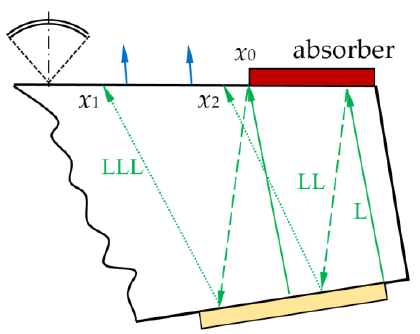
Figure 5. Ray propagation in AO cell with absorber.